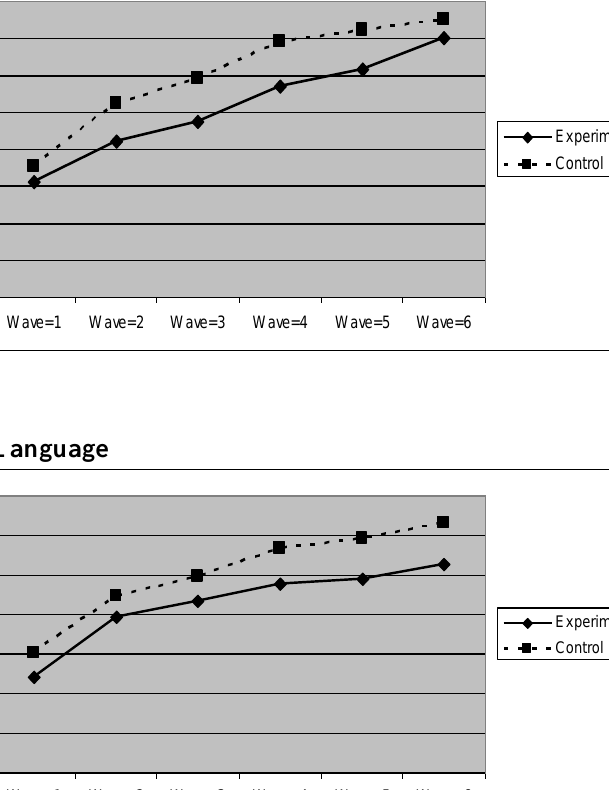
FIGURE 18 . Growth trajectories of the experimental group (Tier 1 participants who perceived the program as effective) and control group using the item score of speaking foul language as the outcome